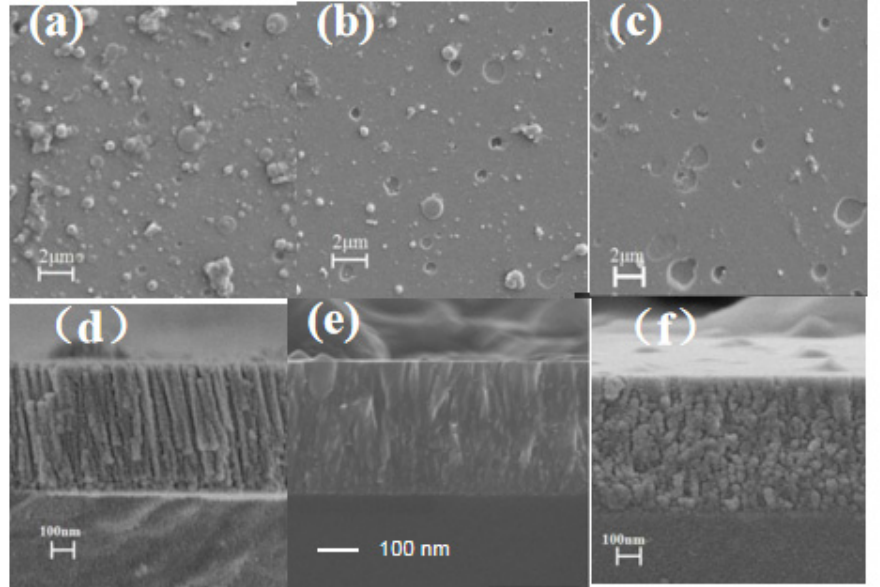
Figure 5. Surface ( a – c ) and cross-sectional ( d – f ) images of Cr–Si–N coatings deposited under bias voltages of 0 V ( a , d ), − 100 V ( b , e ), and − 200 V ( c , f ), respectively.